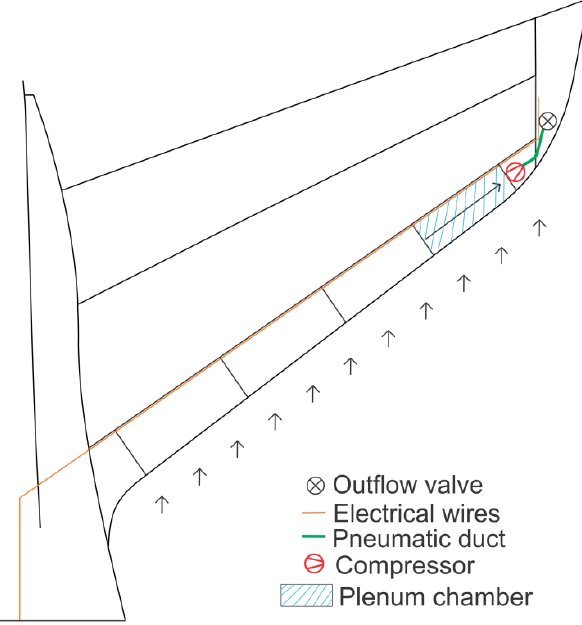
Figure 15. System architecture layout for the studied plenum segment.